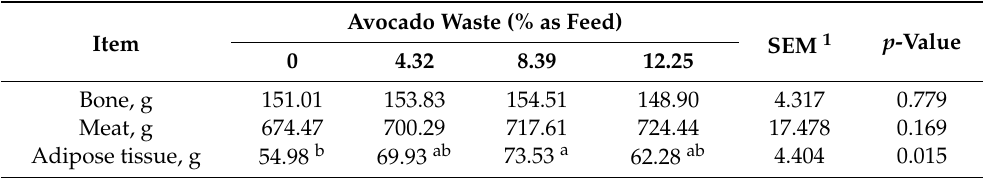
Table 3. Dissectible components of the carcass of fattening rabbits fed diets with different levels of avocado waste.